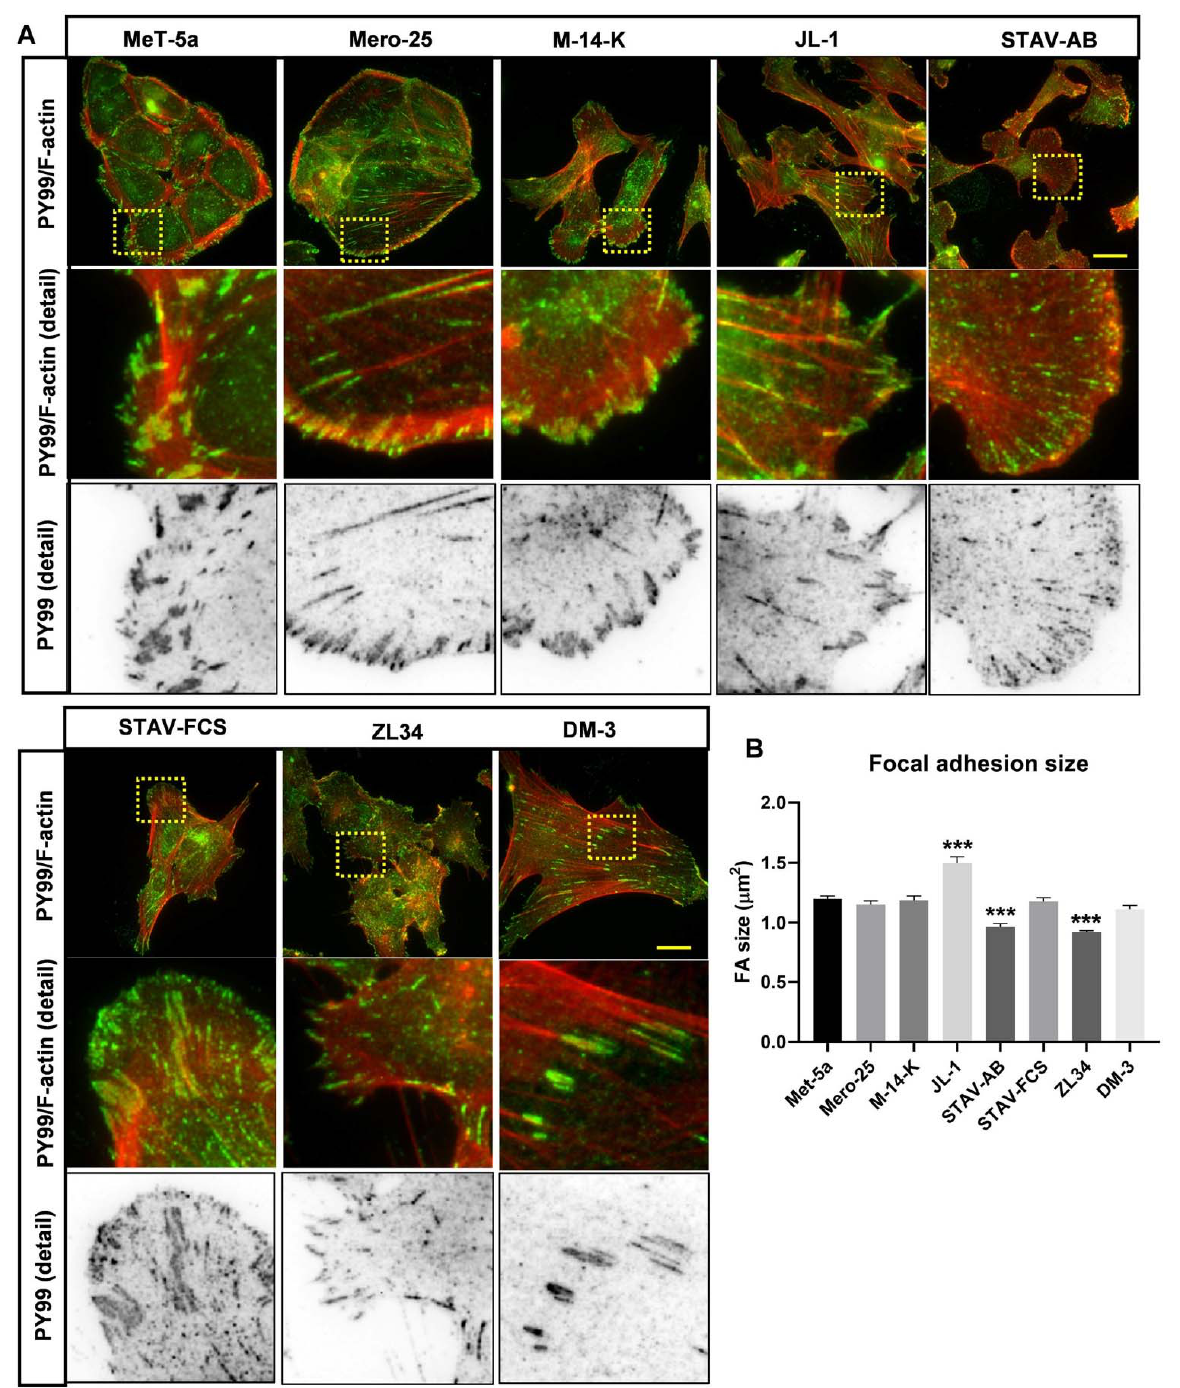
Figure 2. Organization of focal adhesions. ( A ). Representative images for filamentous actin visualized with TRITC - conjugated phalloidin, and for focal adhesions stained with mouse anti-phosphotyrosine (PY99) antibody followed by a AlexaFluor488-conjugated anti-mouse antibody. Scale bar, 20 µm. ( B ). Focal adhesion size were calculated using ImageJ. MeT-5a ( n = 4415), Mero-25 ( n = 3995), M-14-K ( n = 2025), JL-1 ( n = 1454), STAV-AB ( n = 2813), STAV-FCS ( n = 2733), ZL34 ( n = 5637), DM-3 ( n = 2513). Error bars denotes standard error of mean. One-way ANOVA with Tukey’s post hoc analyses were made to calculate statistical significance. *** = p < 0.001 marks the statistical significant difference compared to MeT-5a. A complete list of the significances of the data is presented in Table S2.